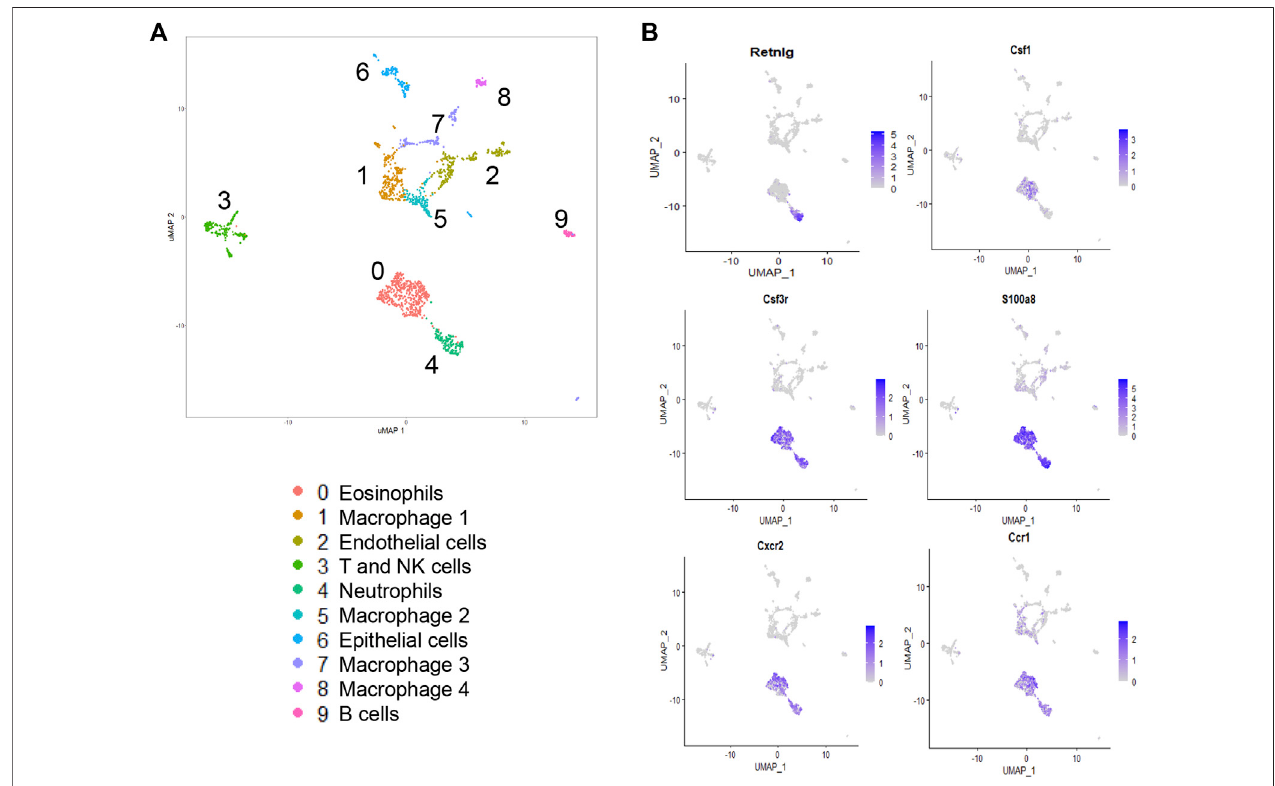
FIGURE1| Single-cell RNAsequencinganalysis oflung tissue digests during SP-C I73T induced acute in fl ammatory exacerbations. Single cell sequencing analysis wasperformedoncollagenasedigestedsinglecellsuspensionsfromSP-C I73T mice14 daysafterinjury. (A) UmapoftheninecellpopulationsclusteredusingtheSeurat analysispackage. (B) Umaps withoverlay ofgene expression expressed solely byneutrophils( retnlg ),eosinophils ( csf1 ),or both but at levels higher thanall other cluster ( csf3 , s100a9 , cxcr2 , ccr1 ).